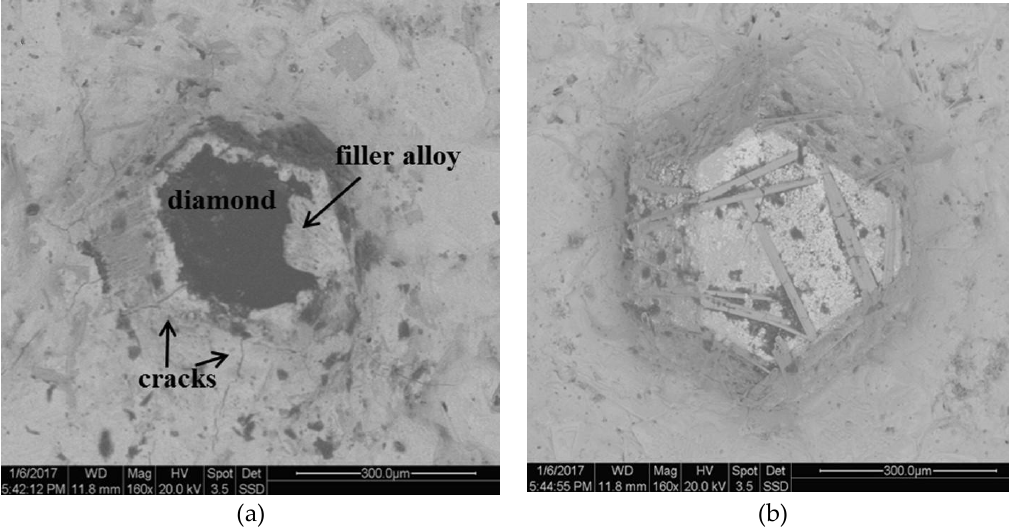
Figure 1. SEM images of diamond-matrix interface: ( a ) uncoated diamond, ( b ) tungsten-coated diamond [35], Taylor & Francis, 2018.